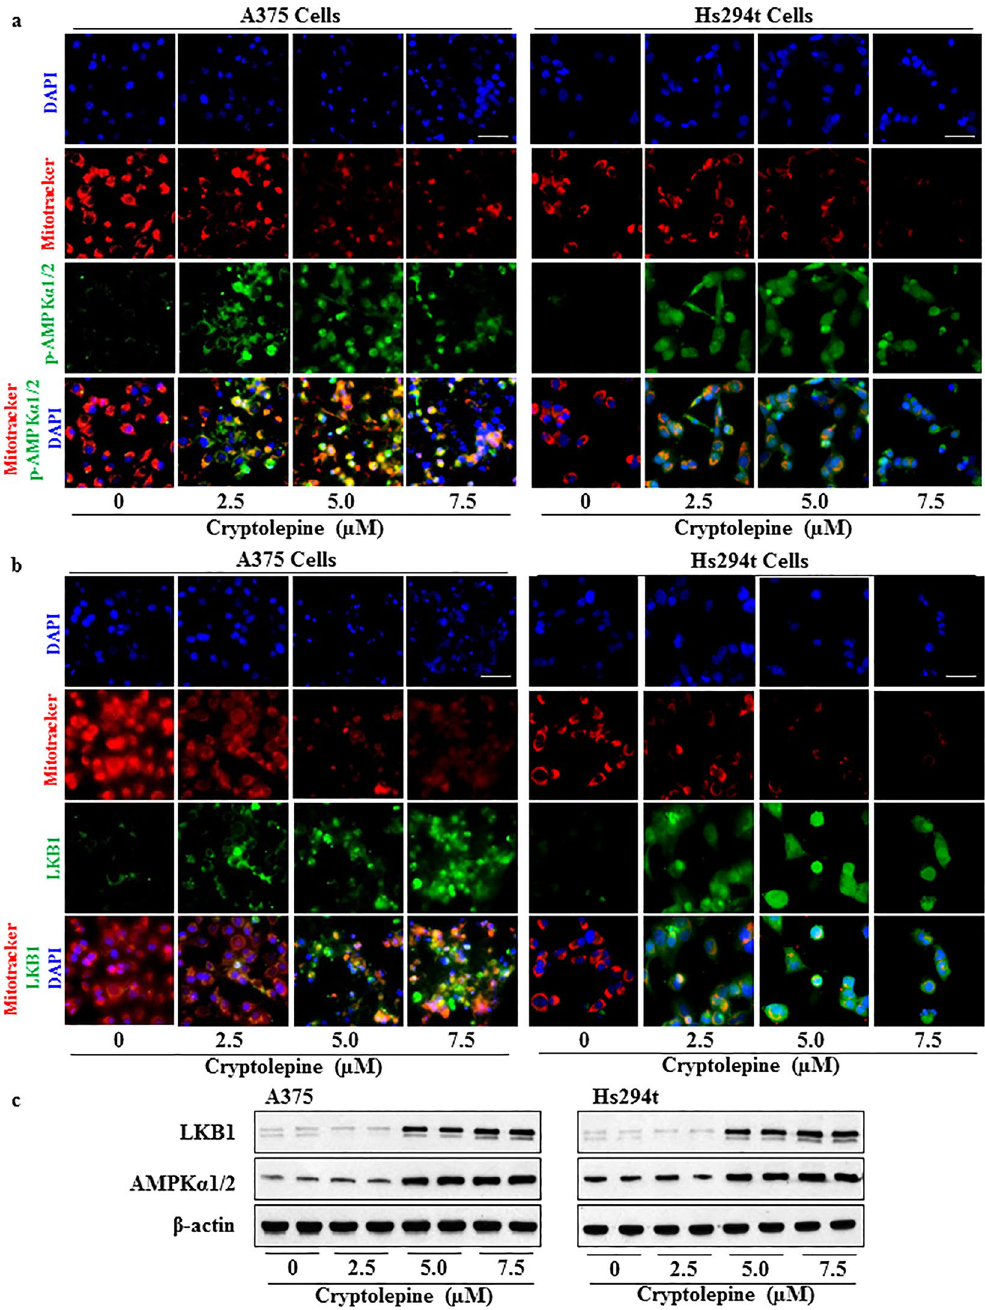
Figure 4. Cryptolepine treatment depletes mitochondria and increases the levels of AMPK α 1/2 and LKB1 in melanoma cells. ( a and b ) Approximately 1x10 5 A375 or Hs294t melanoma cells/well were plated in four-well chambered slides and treated with 0, 2.5, 5.0 and 7.5 µ M cryptolepine for 24 h. Cells were stained with MitoTracker Red for 30 min. After fixation, permeabilization and blocking, cells were incubated with p-AMPK α 1/2 or LKB1 antibodies overnight at 4 °C. Staining was performed as detailed in Materials and Methods. Images were acquired at 40x magnification using a Keyence Fluorescence Microscope BZ- X710 (Keyence Corporation of America). A representative photomicrograph from each group is shown. (c) After treatment of cells with cryptolepine for 24 h, total cell lysates were prepared and subjected to western blot analysis to determine the levels of AMPK α 1/2 and LKB1 proteins. Blots were developed using chemiluminescence-specific ECL detection agents. Equal loading of proteins was verified by stripping the membrane and reprobing with anti- β -actin